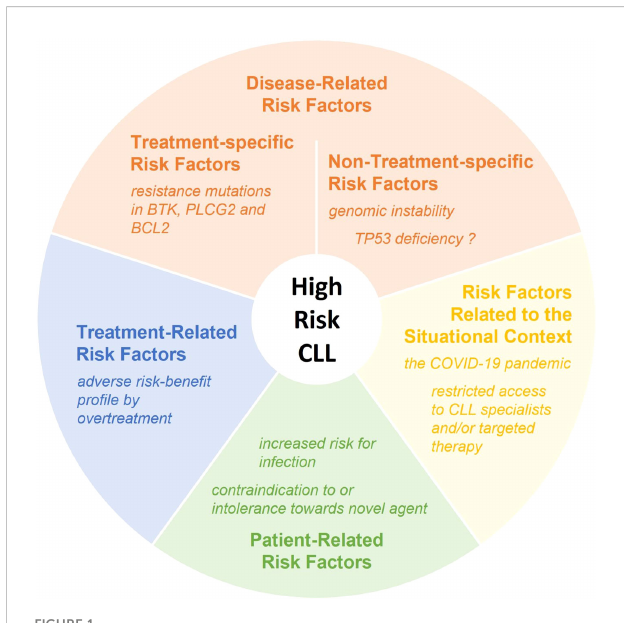
FIGURE 1 Factors increasing the risk for early CLL-related death. Examples are provided for each category of risk